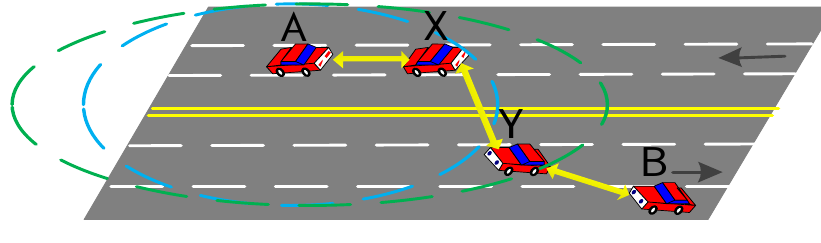
Figure 9. Potential collision detection.